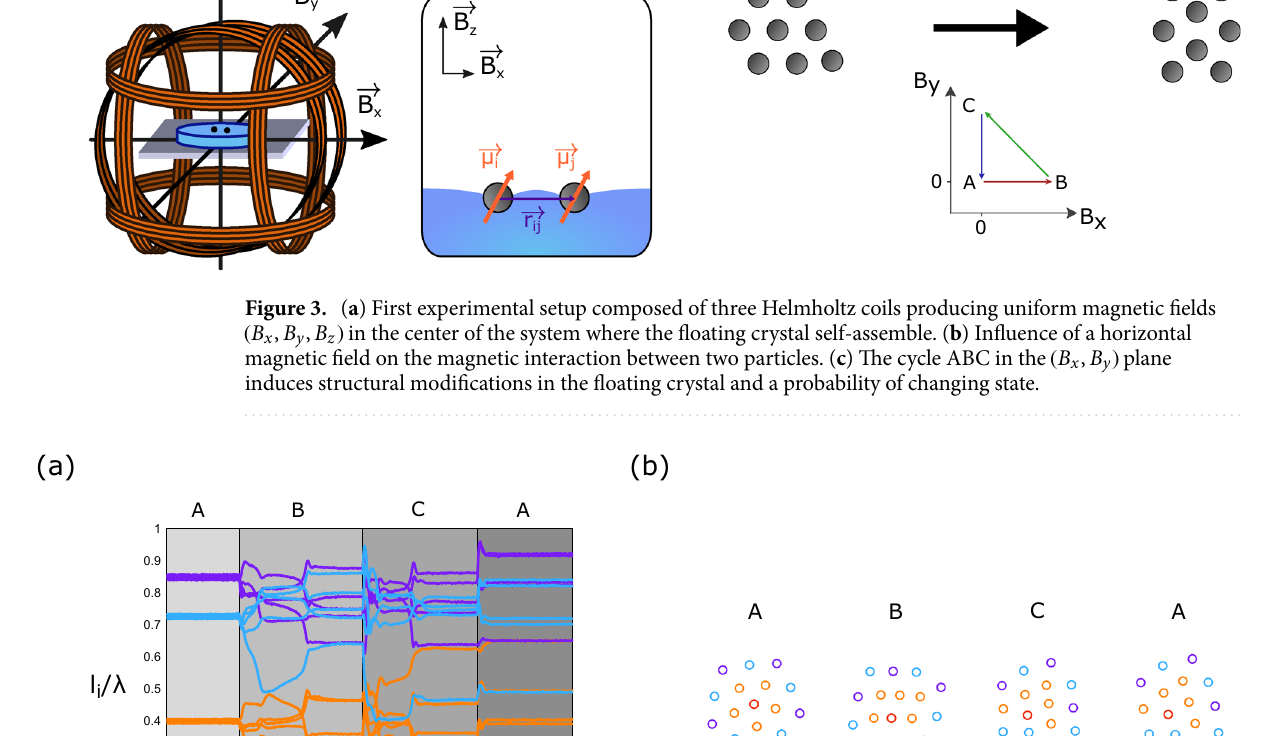
Figure 4. Experimental results about the transition between S16b and S16d for B z normalized distance ( l i / (cid:31) ) of each bead i to the center of mass of the assembly as a function of time. Four steps will be observed corresponding to stages A, B or C of the cycle in the ( B x , B y ) space (see Fig. 3c). These phases are shown on the graph and corresponding assembly stable states are drawn in ( b ). The beads and their normalized distance ( l i / (cid:31) ) are colored according to their distance from the center of mass in the initial state